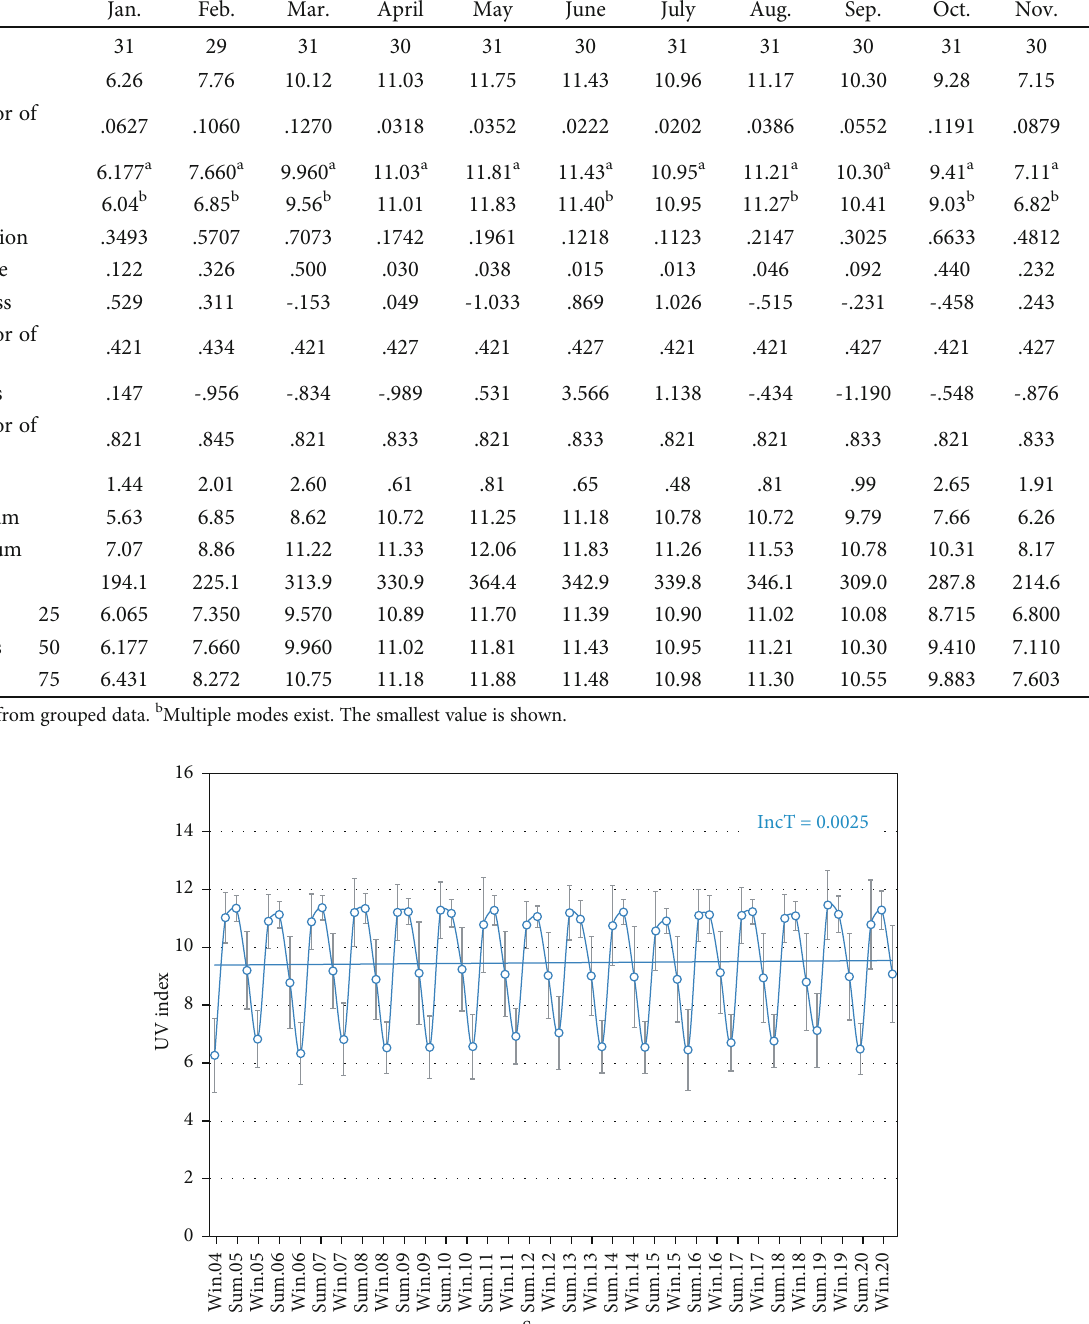
Table 3: Analysis of the mean monthly UVI during the study period at KAU. Jan. Feb.